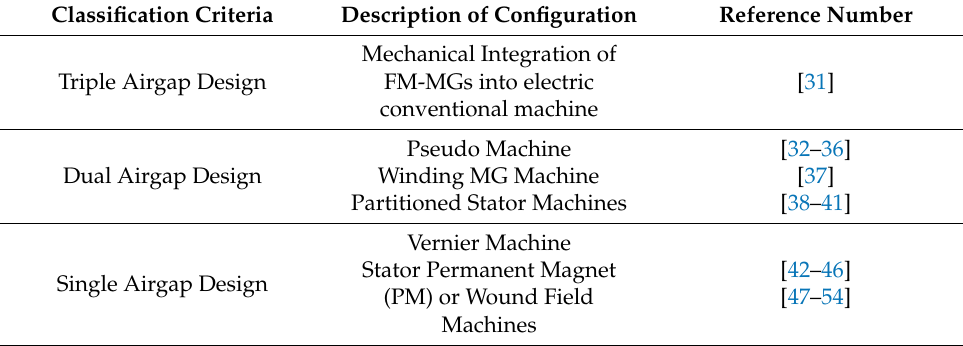
Figure 3. Schematic diagram of Magnetically Geared Machines (MGMs). Table 2. Summary on MGMs